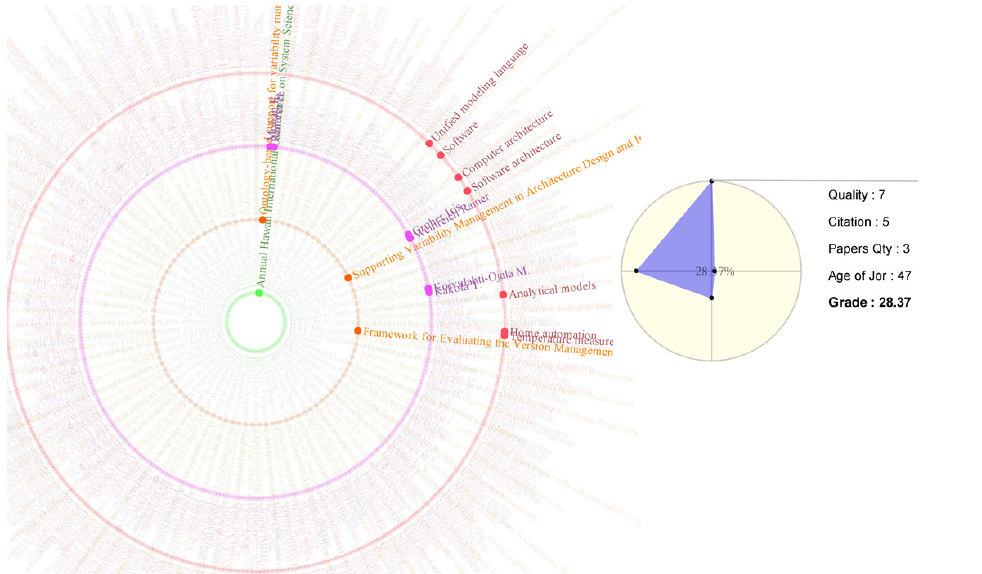
Figure 16. A journal has been